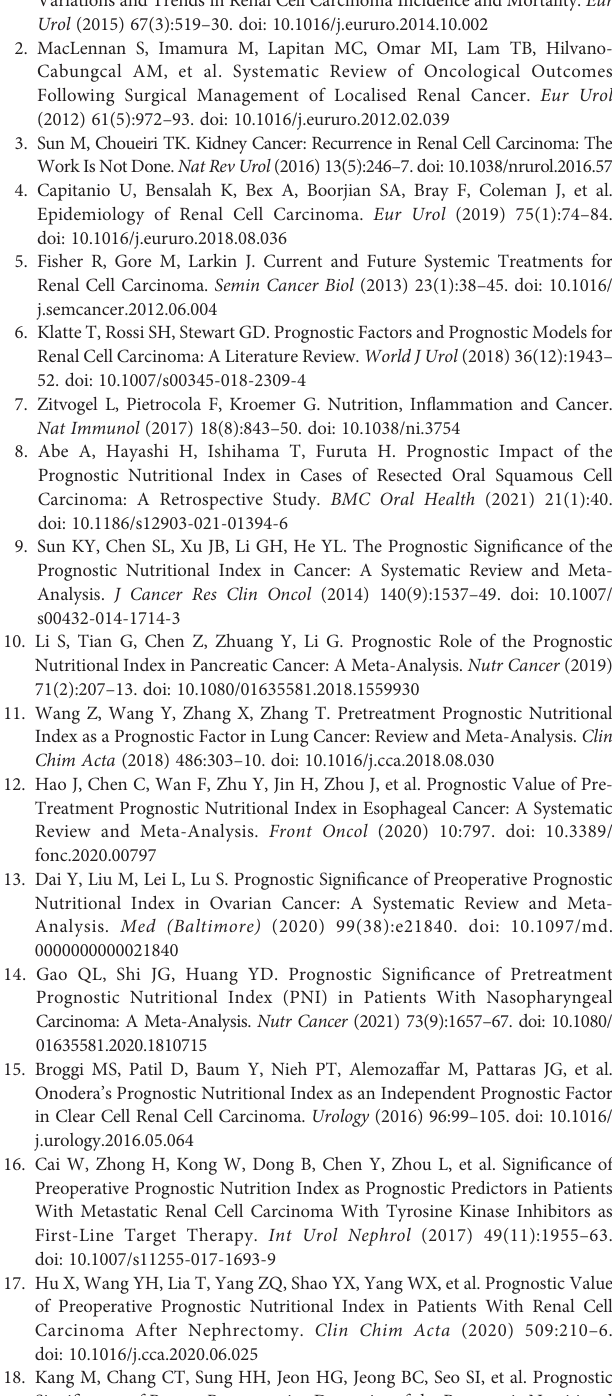
Supplementary Figure 1 | Forest plot examining the association between PNI and OS in patients with RCC. (A) subgroup analysis by various metastatic status of disease; (B) subgroup analysis by histological types of RCC.